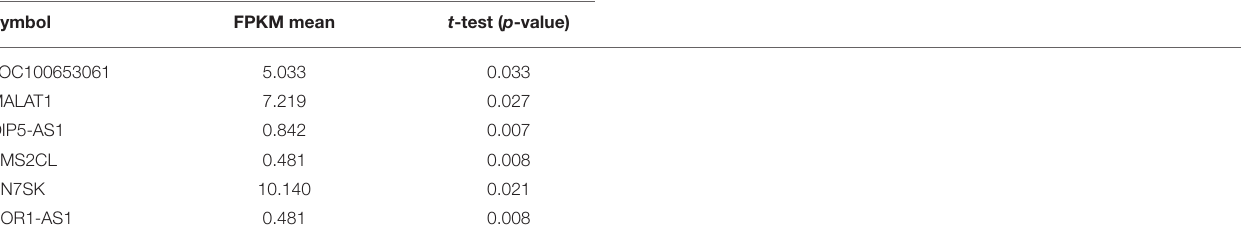
( Figure 3A), primary (Figure 3B ), secondary ( Figure 3C ), as well as small pre-antral/early antral follicles ( Figures 3D–F) . As the TAF15 protein appears detectable in both oocytes and the surrounding somatic cells are in line with the RNA sequencing